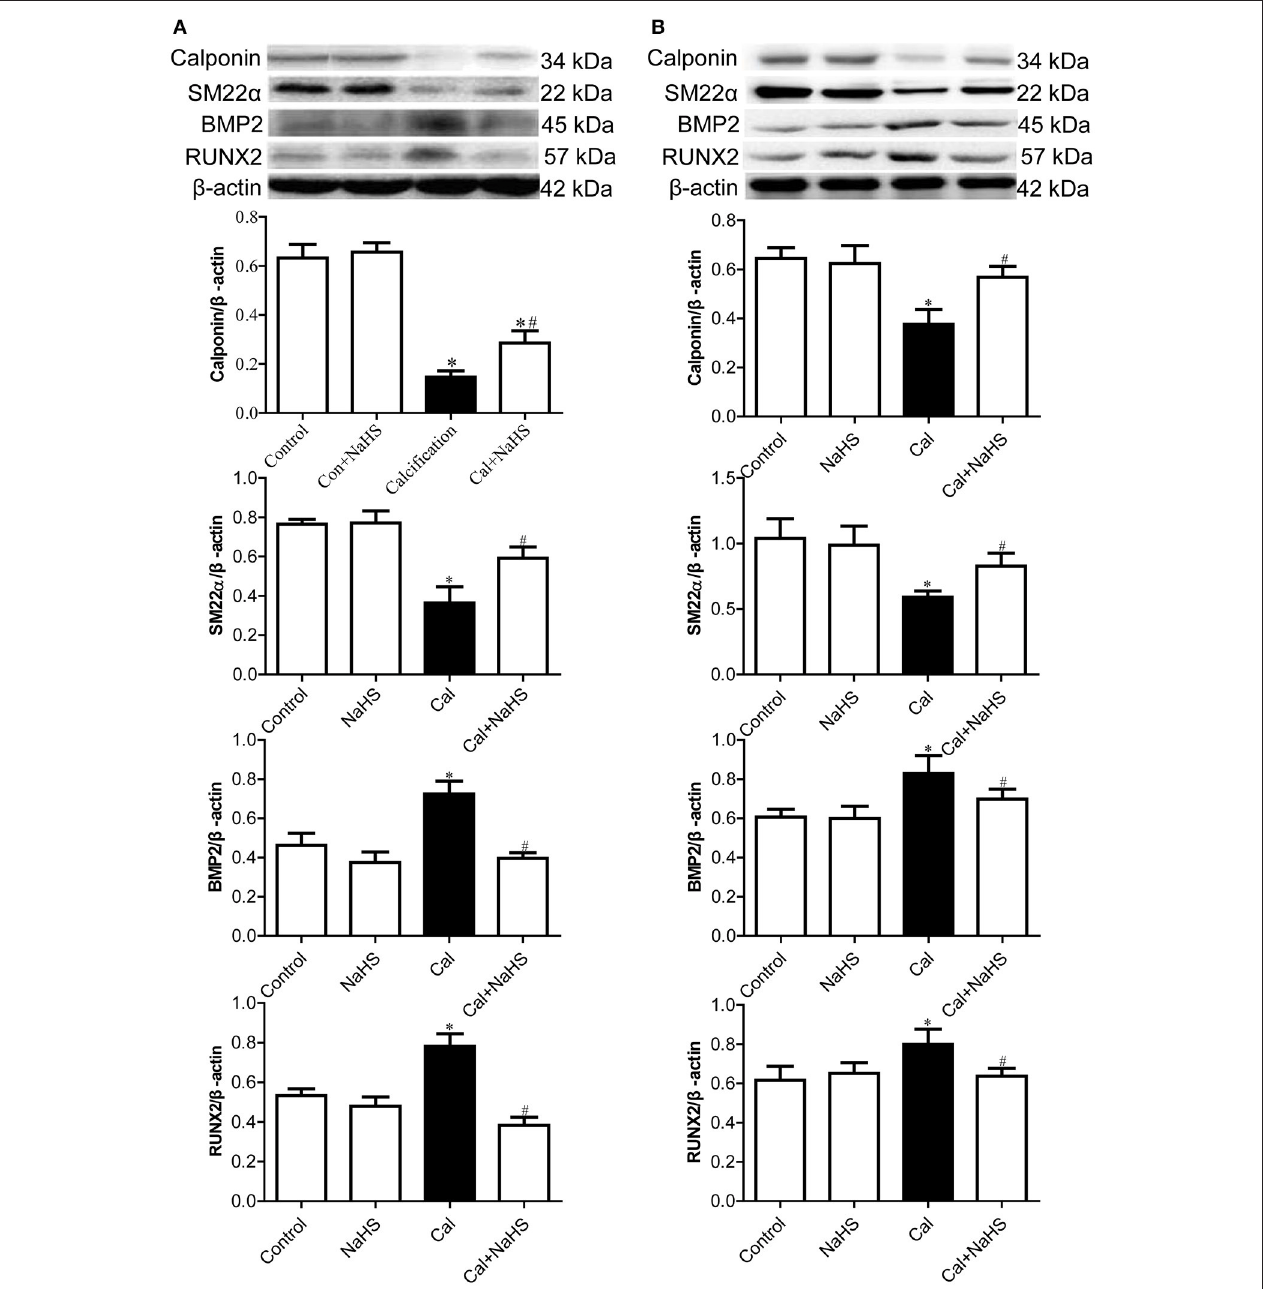
FIGURE 2 | Protein expression of contractile phenotype and osteoblast-like phenotype markers of vascular smooth muscle cells in aorta (A) and carotid artery (B) . Data are mean ± SD. * P < 0.05 vs. control; # P < 0.05 vs. Cal. ( n = 8 each group).